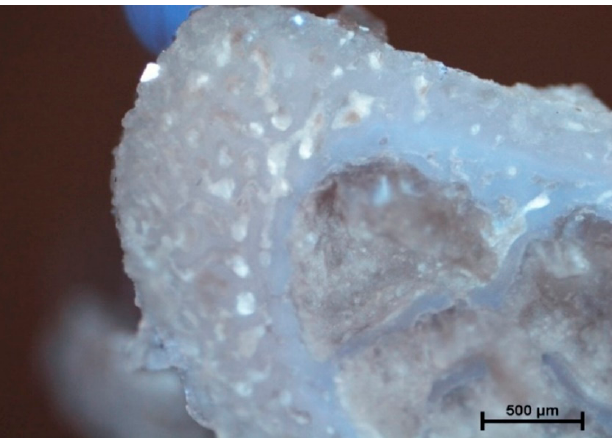
Figure 4. Rotation of 1200 rpm (20 °C). The apical area of rib filled with connective tissue. The lack of strong tissue compression areas caused by the drill.